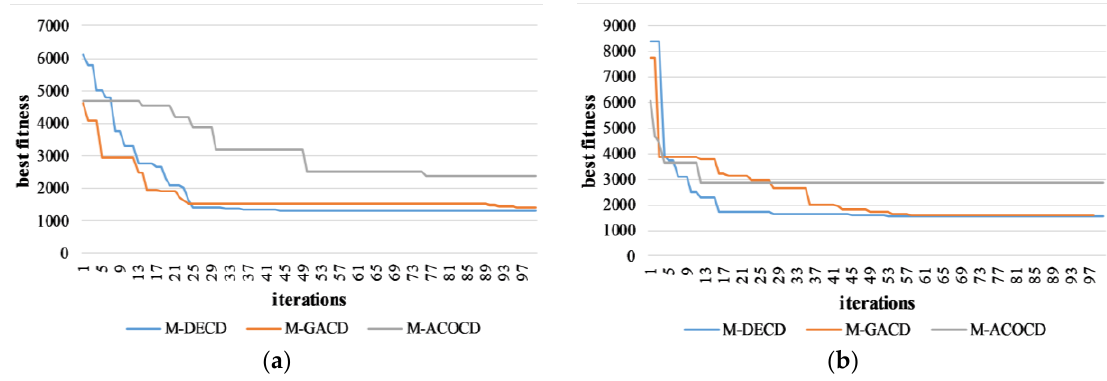
Figure 15. Convergence analysis of GA, ACO, and DE in the multi-feature clustering-based CD framework. ( a ) Convergence process of different EAs for the Sardinia dataset. ( b ) Convergence process of different EAs for the Alaska dataset.